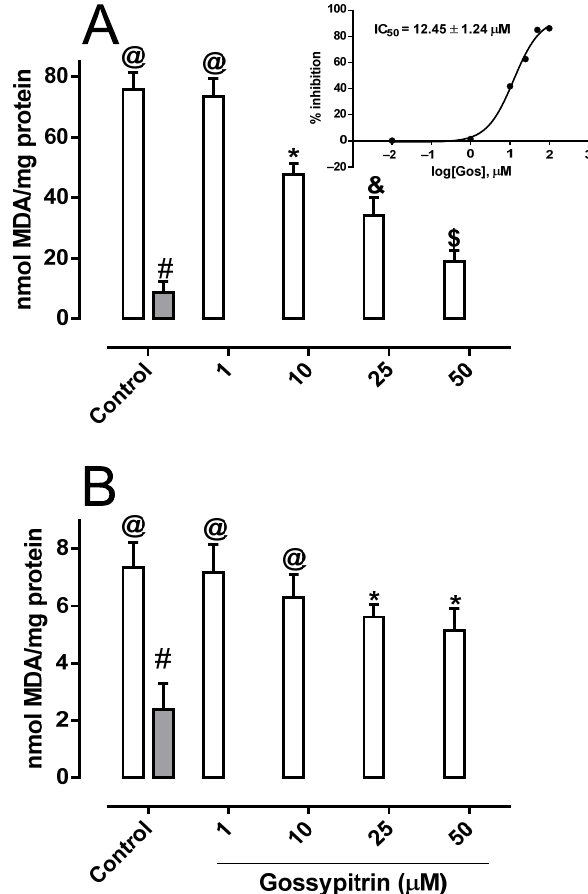
Figure 3. Gos inhibits malondialdehyde formation in the mitochondria, induced by 50 µ M Fe(II)- citrate ( A ) or 300 µ M tert -butyl hydroperoxide ( B ). Rat brain mitochondria (1 mg/mL) were incubated in a reaction medium containing 125 mM sucrose, 65 mM KCl, 10 mM HEPES buffer (pH 7.4), 2 mM succinate, and 2.5 µ M rotenone, with or without Gos (1–50 µ M). The experiments started by the addition of 50 µ M Fe(II) or 300 µ M tert -butyl hydroperoxide, except for the undamaged Control (gray bars). The incubation period was 20 min at 28 °C. Values are the means ± S.D. ( n = 6). Different symbols indicate statistical differences at p < 0.05 when comparing all experimental groups according to the ANOVA and post hoc Newman-Keuls tests. (If the symbols are different among groups indicate statistical differences, when they are equal, there is